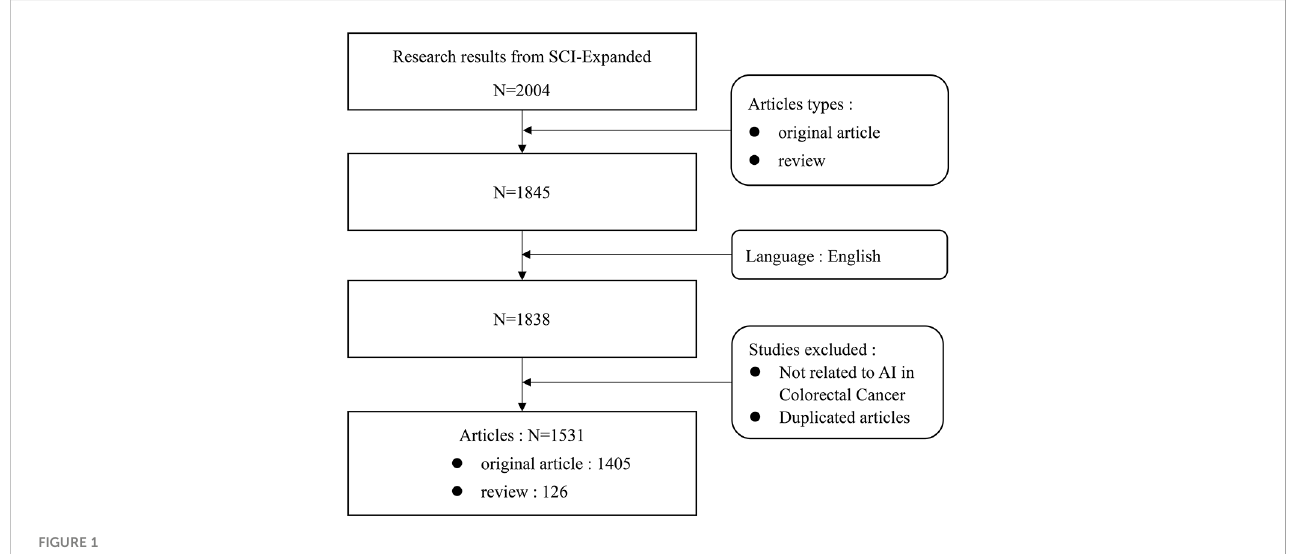
FIGURE 1 Flowchart of literature